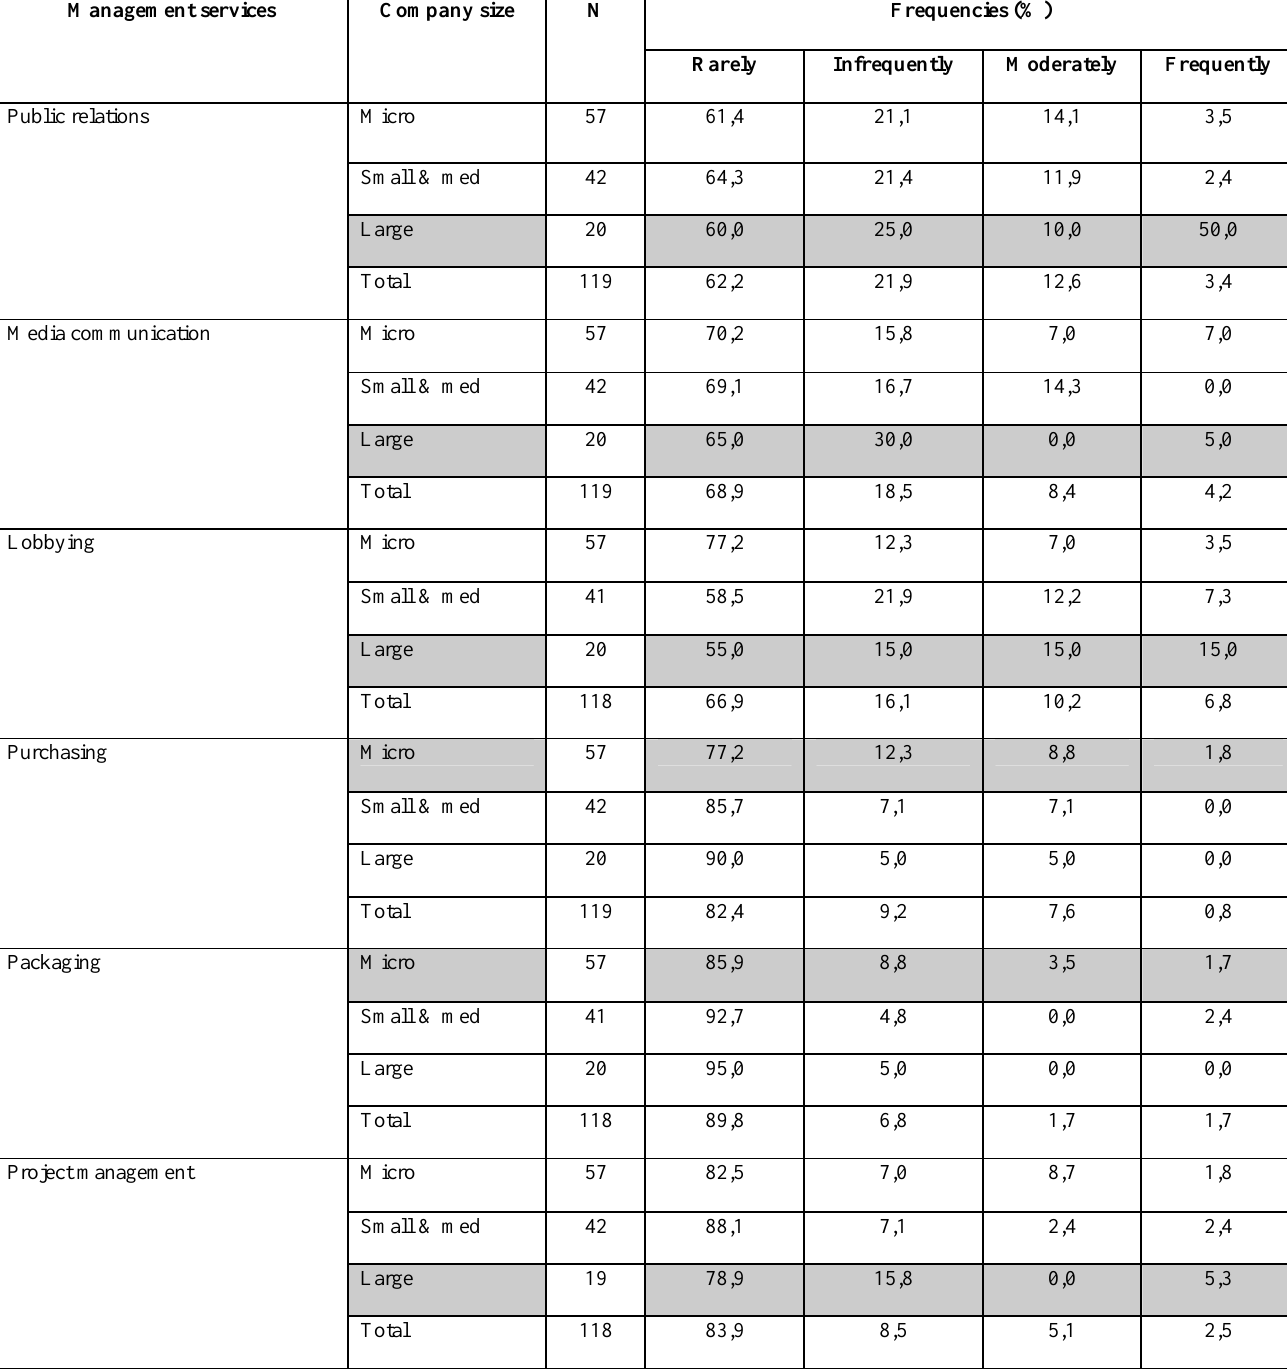
Table 4: Comparison between company size and responses to management